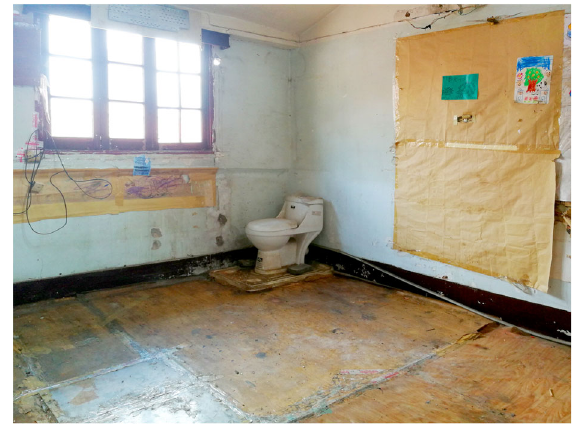
Fig. 8 It is impossible to distinguish between dirty areas and clean areas in one living space. In general, the average living space for each family is nine square meters (Source: Kaiyi Zhu,